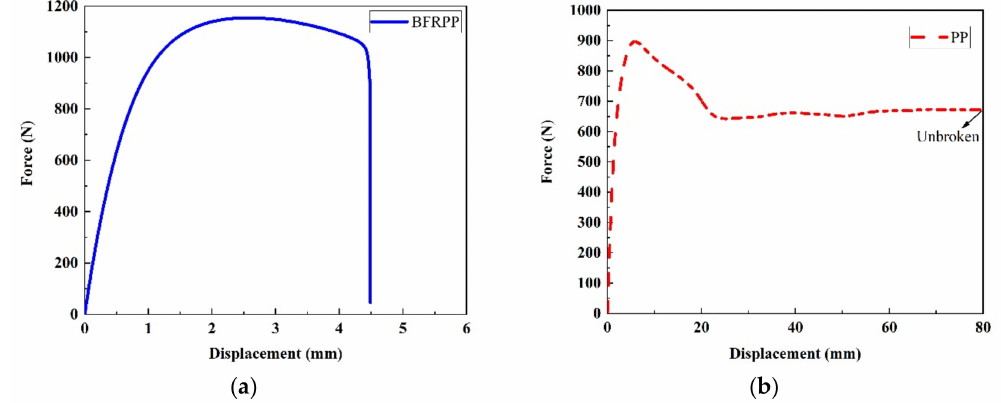
Figure 3. The typical force–displacement curves: ( a ) PP; and ( b )